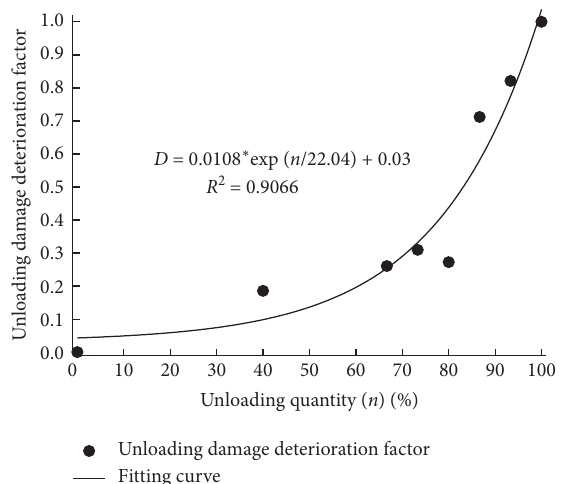
Figure 8: The curve of the unloading damage deterioration factor and unloading